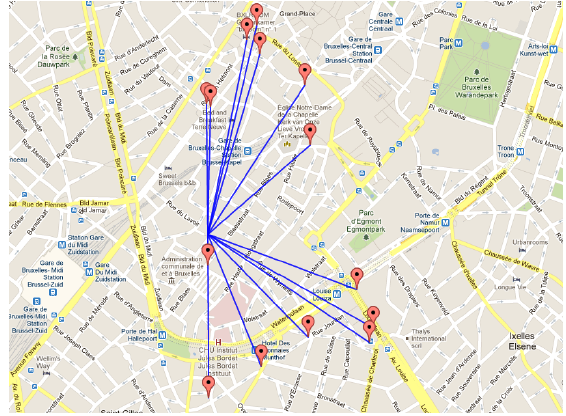
Figure 10. Swimming pools and restaurants less than 1 km away from each